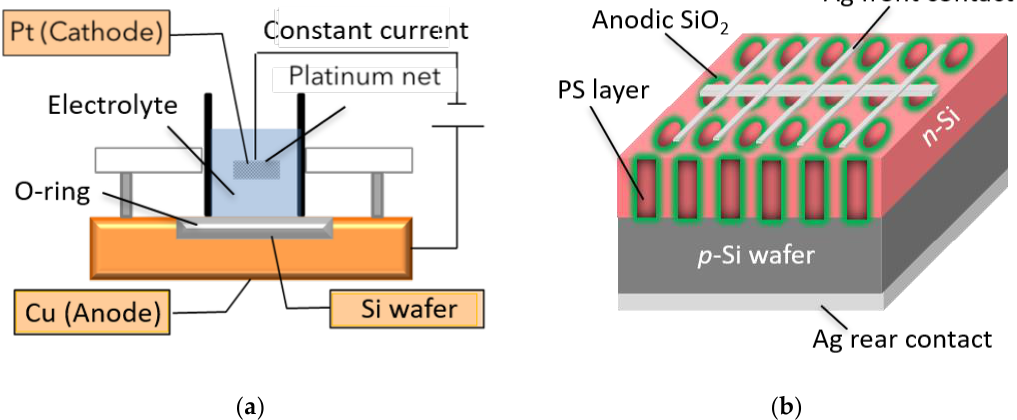
Figure 1. Schematic of ( a ) electrochemical etching set-up; ( b ) solar cells based on porous silicon (PS). With this fabrication condition, PS layers of different thicknesses and an average porosity of 38% were prepared on c -Si substrates. A porosity of 38% was calculated based on the effective medium approximation (EMA) with Bruggeman’s Model [30] and is optimal to achieve a low lattice-mismatch between the PS layers and c -Si substrate. For the surface passivation, a thin SiO 2 film was formed to cover the surfaces of the pores on the PS layer by the anodization method in H 2 O/HCl at ambient temperature. The anodization reaction is as